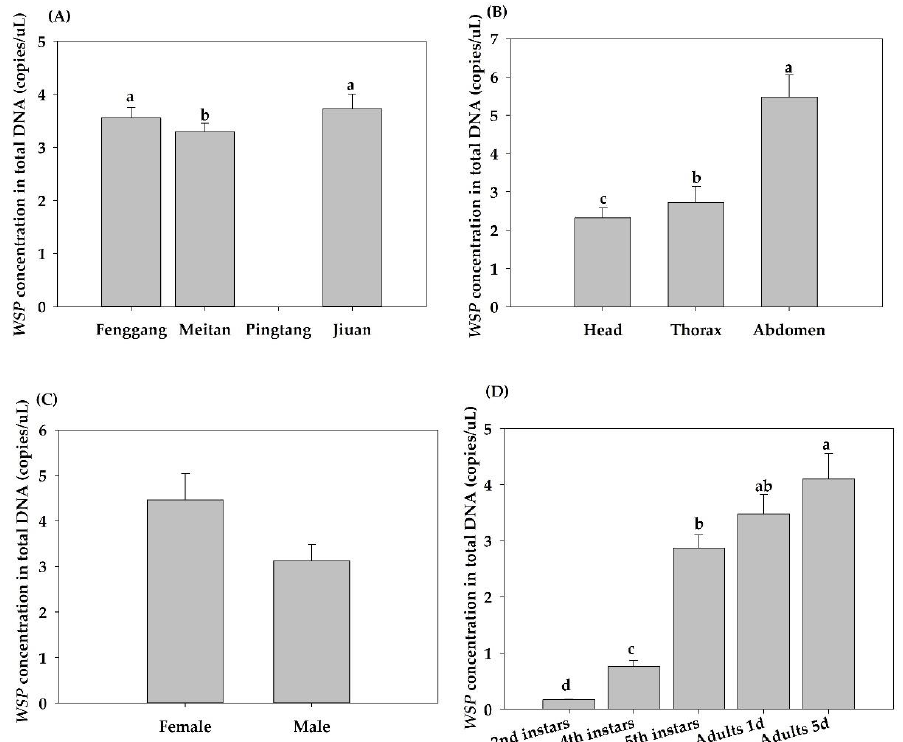
Figure 3. The relative amounts of wsp gene to total DNA (copies/ µ L) in different samples of tea green leafhopper. ( A ) Whole adult insects from four geographical locations. ( B ) Body parts of insects in adult stage. ( C ) Whole insect body of female and male. ( D ) Whole insects in different development stages. Different letters indicate significant differences at p ≤ 0.05.